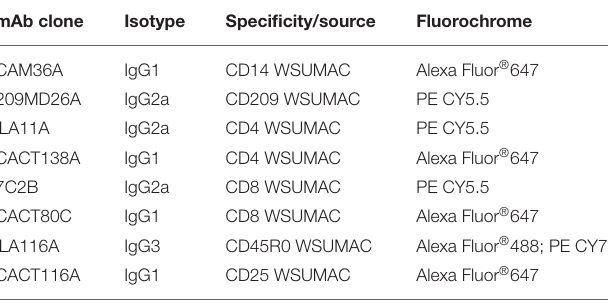
TABLE 1 | mAbs used in the present